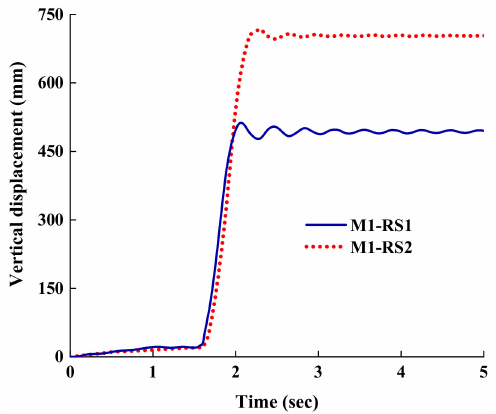
Figure 30. Response of model M1 subjected to truck impact of column D5.